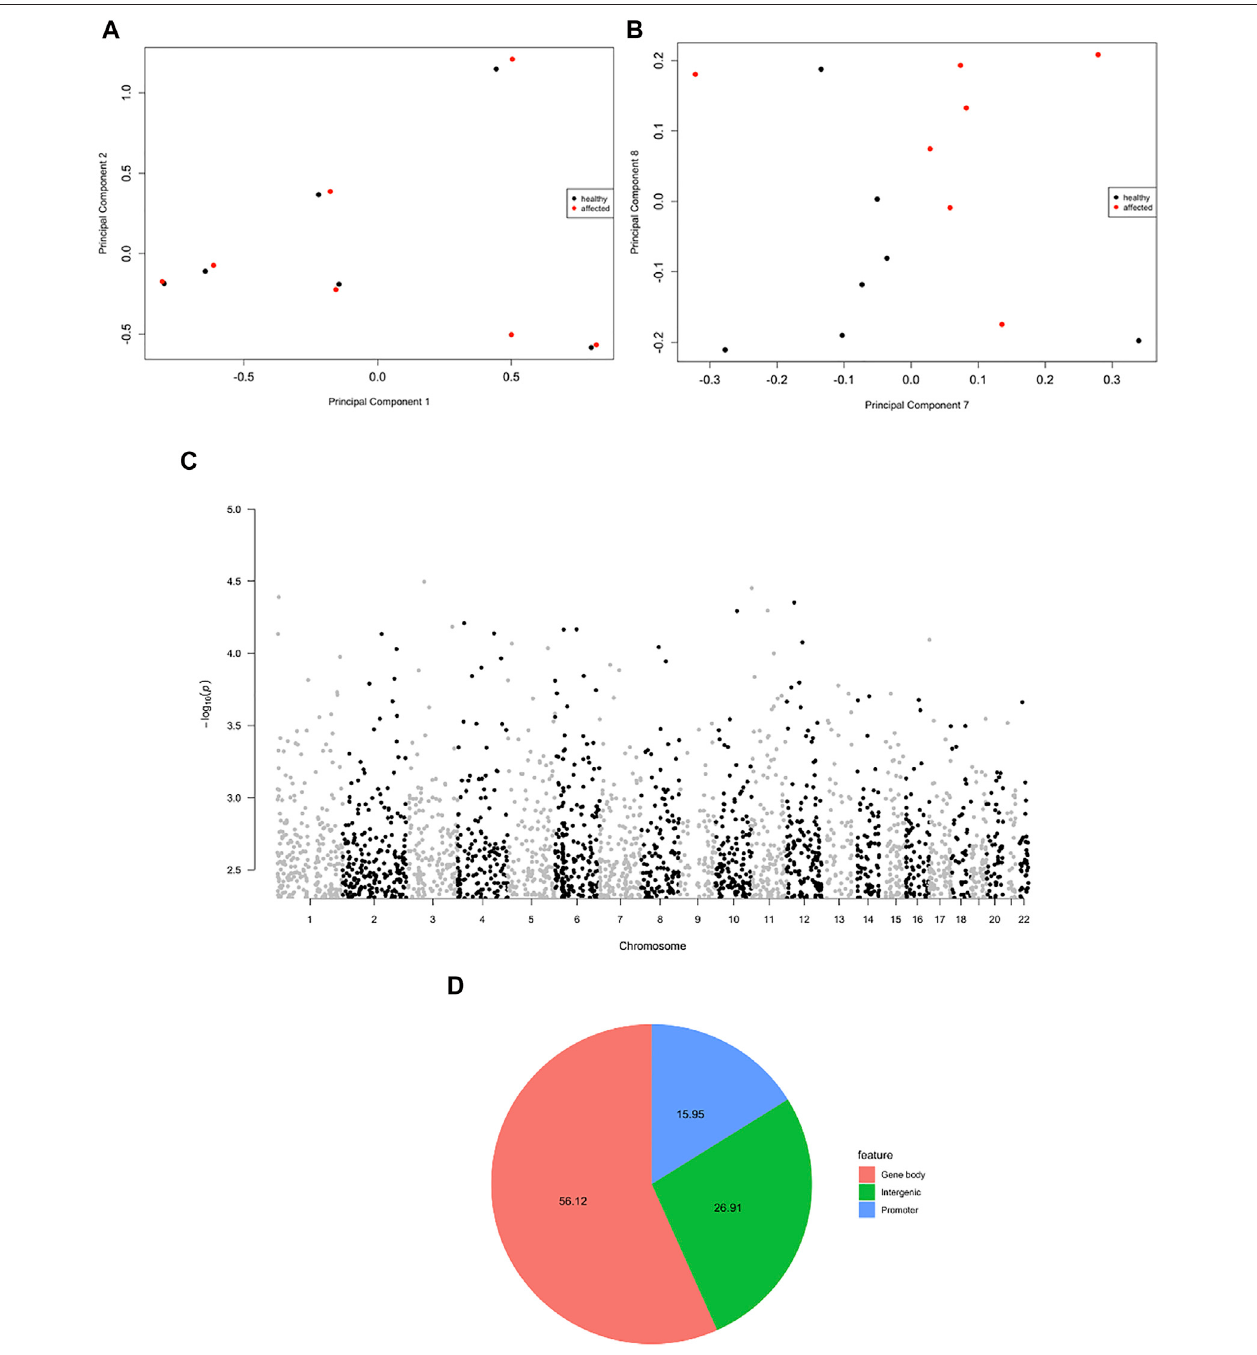
FIGURE 2 | Evidence for psoriatic disease-associated differential DNA methylation in whole blood MZ twins. (A,B) A multi-dimensional scale (MDS) plot of all samplesisshown,consideringthe fi rsttwocomponents (A) andthedimensionssevenandeight (B) . (C) Manhattanplotshowingthedistributionofthesigni fi cantDMPs ( p < 0.005) in the genome. (D) Pie chart showing the genomic localization of the DMPs.